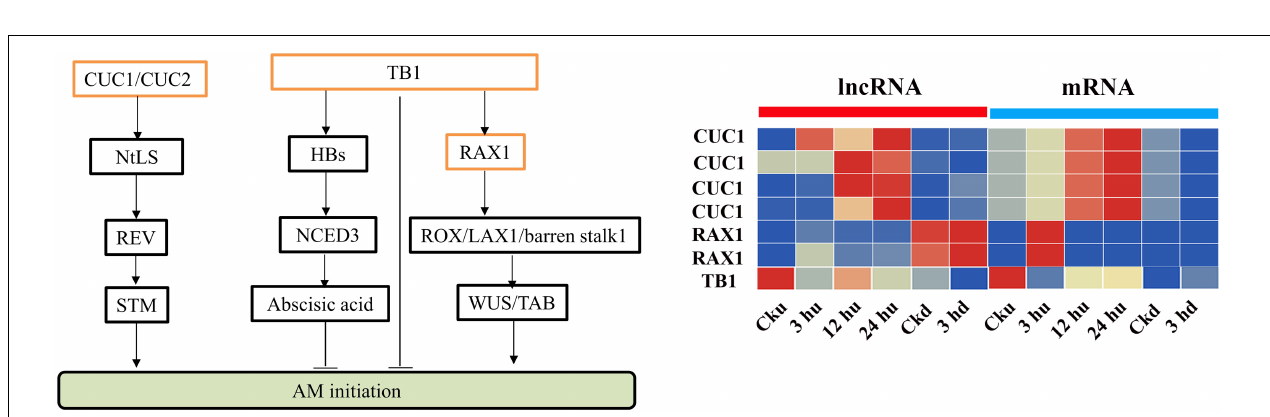
FIGURE 4 | Expression patterns of lncRNAs and mRNAs involved in glycometabolism of upper and lower axillary bud. All the heatmaps were generated using Tbtools software with log 2 transformed FPKM values.